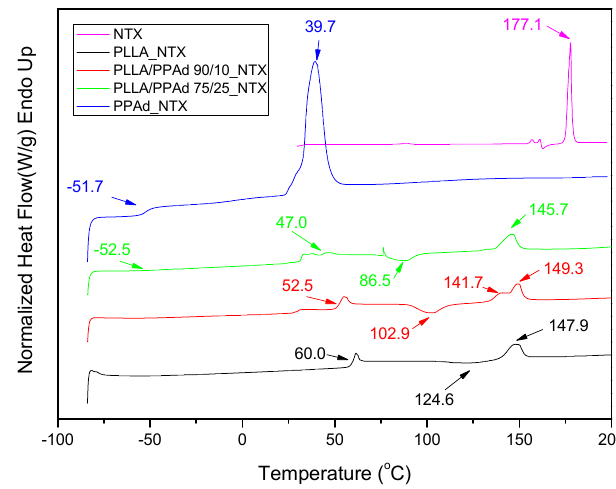
Figure 13. DSC thermograms of neat naltrexone and PLLA, PPAd, and PLA-b-PPAd 90 / 10 and 75 / 25 w / w microspheres loaded with